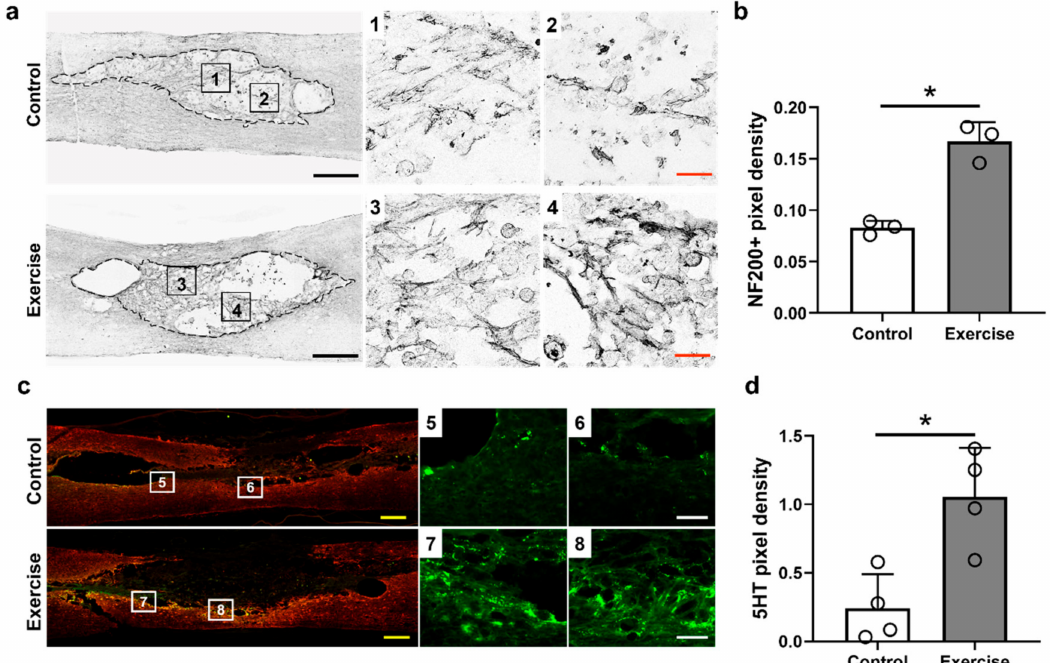
Figure 5. NF200 DAB staining results ( a , b ) and 5HT immunohistochemical results ( c , d ) in the injured spinal cord tissue at 12 weeks after injury ( a – d ). ( a ) Representative images of NF200-positive axons in the control and exercise groups. The right images are high-magnification images of the black boxes in the left images (Nos. 1–4) within the lesion cavities of contused spinal cords (outlined by black dashed lines). ( b ) The density of NF200-positive axons of the control and exercise groups ( n = 4 per group). ( c ) Representative images of 5HT-positive axons (green) and GFAP-positive astrocytes (red) in the control and exercise groups. The right images are high-magnification images of the black boxes in the left images (Nos. 5–8) adjacent to the lesion cavities of contused spinal cords. ( d ) The density of 5HT-positive axons of the control and exercise groups ( n = 4 per group). * p < 0.05 between the control and exercise groups by Mann–Whitney U test. Black and yellow scale bars = 500 µ m, white scale bar = 100 µ m, red scale bar = 50 µ